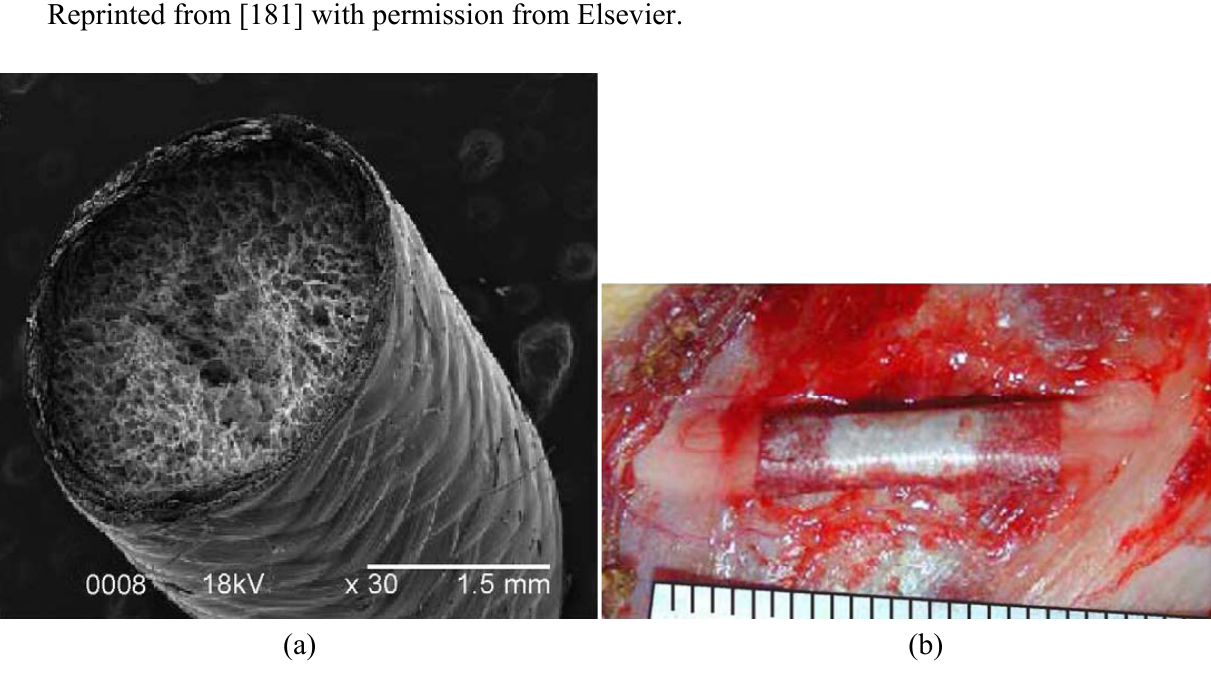
Figure 5. ( a ) SEM image of polyglycolide (PGA)-collagen nerve conduit filled with collagen sponge and ( b ) the intraoperative view of the conduit after implantation. Reprinted from [181] with permission from